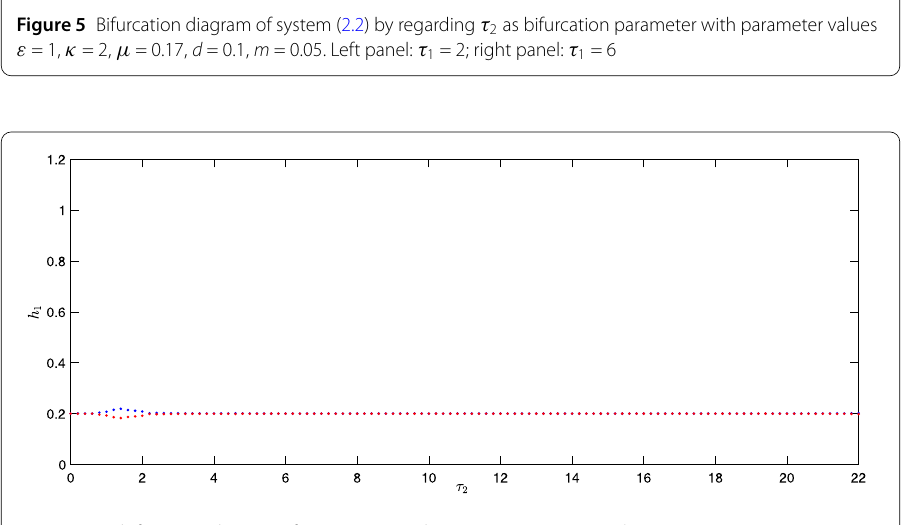
Figure 6 τ 2 -bifurcation diagram of system (2.2) with ε = 1, κ = 2, μ = 0.17, d = 0.1, m = 1, τ 1 =